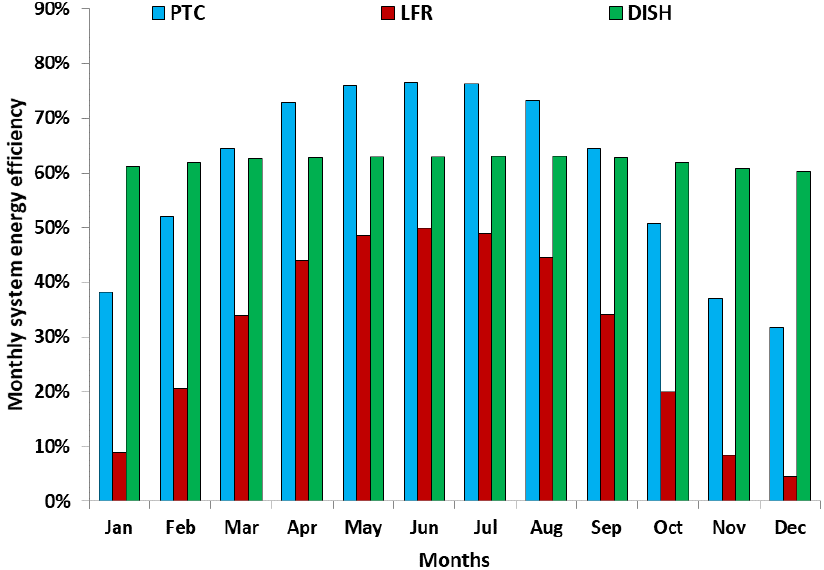
Figure 12. Monthly system energy efficiency for the three solar collectors.